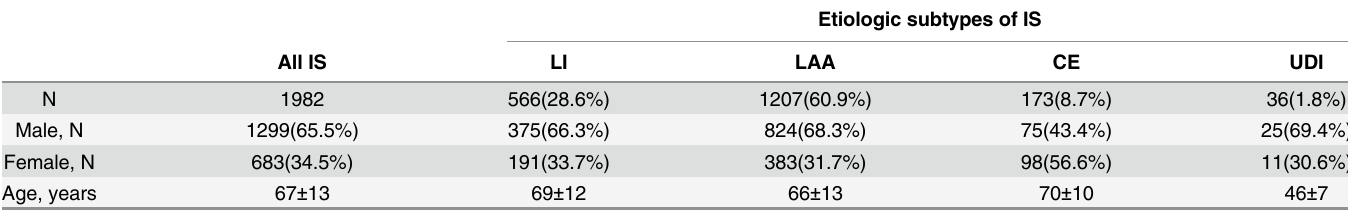
Table 1. Characteristics of patients stratified by ischemic stroke (IS)